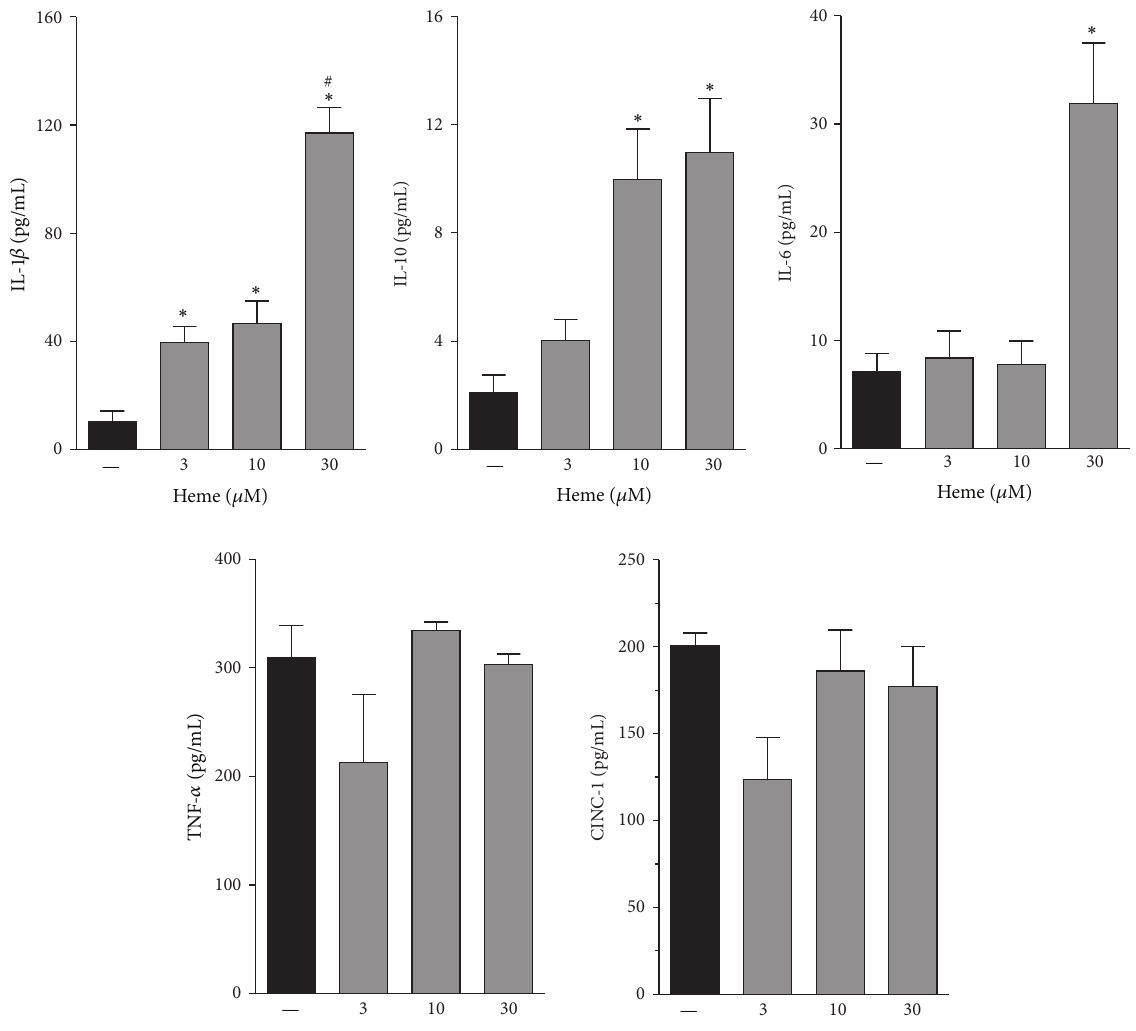
Figure 3: Heme modulates cytokine secretion in AM. Rat AMs ( 1 × 10 6 /mL) were treated with different concentrations of heme (3–30 𝜇 M) for 3 h. The culture supernatants were subsequently collected and analyzed for IL-1 𝛽 , IL-6, IL-10, TNF- 𝛼 , and CINC-1 secretion by ELISA. The data shown are representative of three independent experiments. The mean ± S.D. is presented. ∗ 𝑃 < 0.05 when compared with untreated cells; # 𝑃 < 0.05 when compared to heme 3 and 10 𝜇